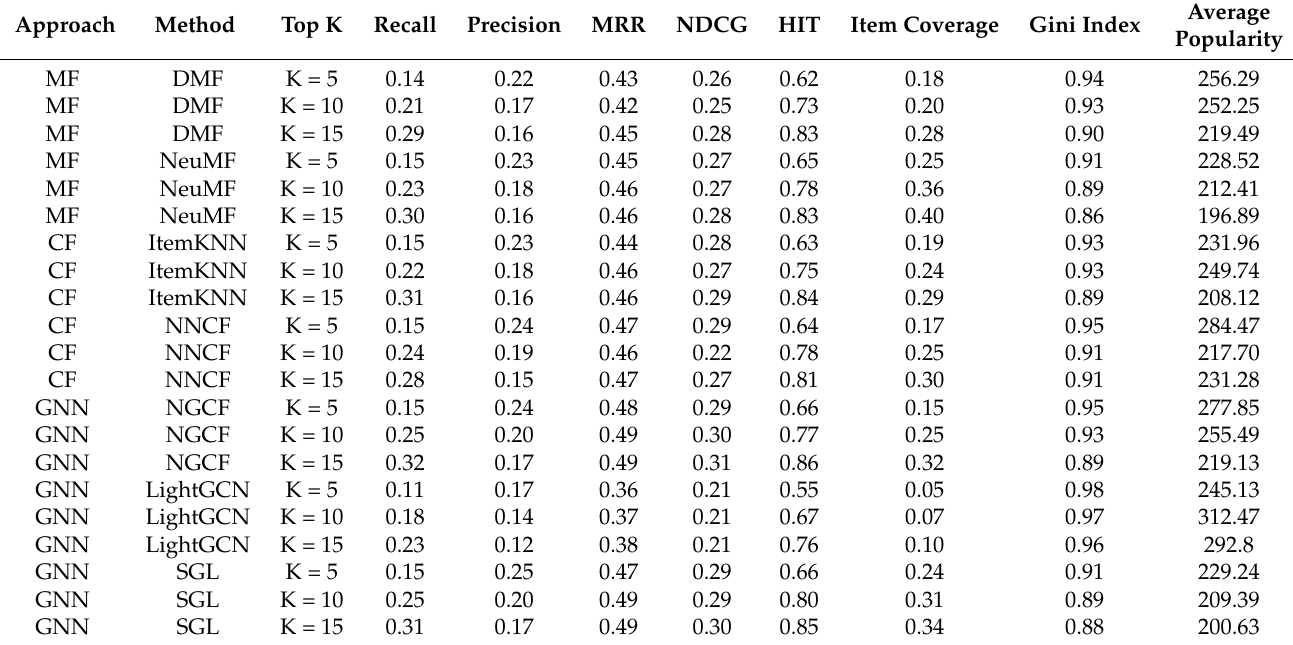
Table 7. Results on the MovieLens